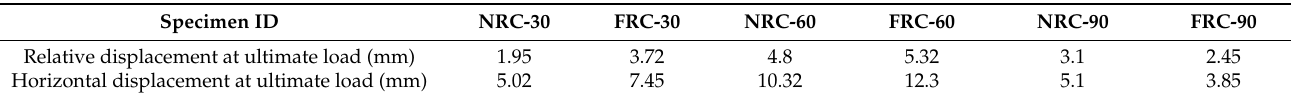
Table 6. Relative displacement and horizontal displacement at ultimate load.